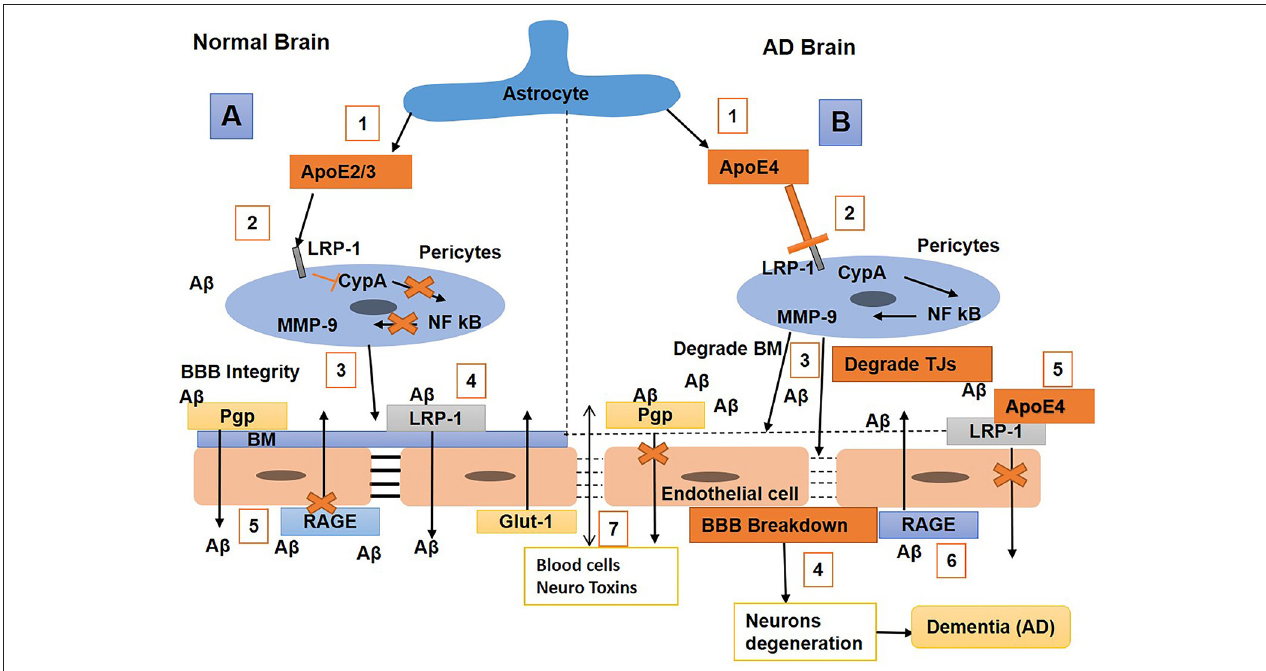
FIGURE 5 | Schematic diagram shows the mechanisms of blood–brain barrier (BBB) breakdown in a normal brain and one with Alzheimer’s disease (AD). (A) Normal brain (1) Astrocytes release ApoE2/3, (2) bind with the low-density lipoprotein receptor-related protein-1 (LRP-1) on pericytes and repress CypA-NFkB, which, in turn, stops matrix metalloproteinase 9 (MMP9) secretion in pericytes; (3) hence, maintaining BM and BBB integrity, with (4) LRP-1 and P-gp on endothelial cells (ECs) also helping in amyloid-beta (A β ) clearance. (5) Receptor for advanced glycosylation end products (RAGE) expression is repressed to stop the transport of A β into the brain. (B) AD brain (1) Astrocytes secret ApoE4, (2) weakly interact with LRP-1 on pericytes which activates the cyclophilin-A nuclear factor k β matrix metalloproteinase 9 (CypA-NFkB-MMP9 pathways), (3) and result in BM and tight junctions (TJs) degradation leading to BBB breakdown, (4) associated